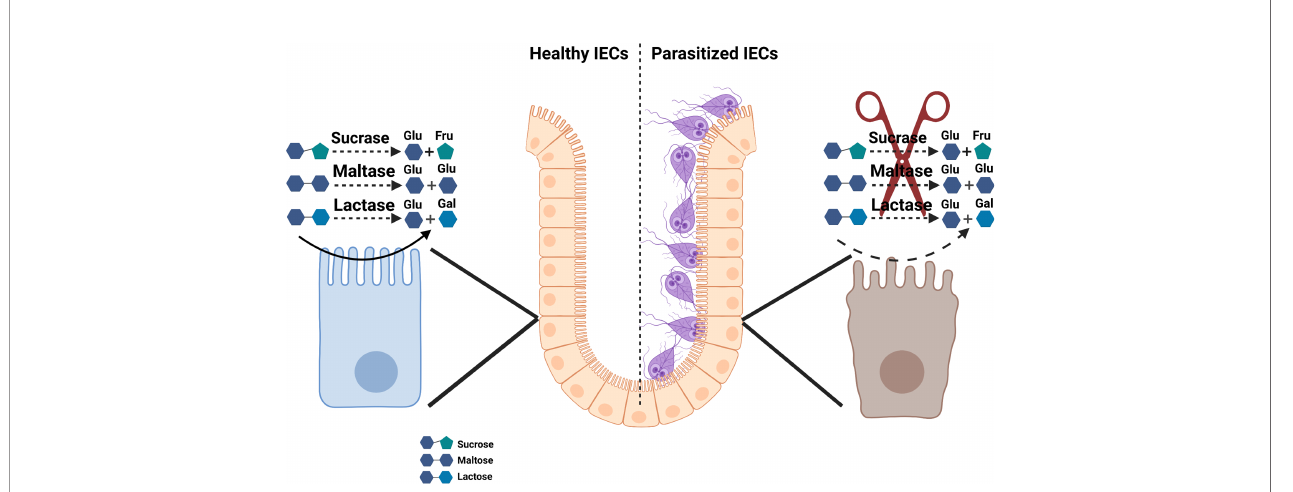
FIGURE 2 | Schematic model of disaccharidase de fi ciency following infection with Giardia infection in vivo